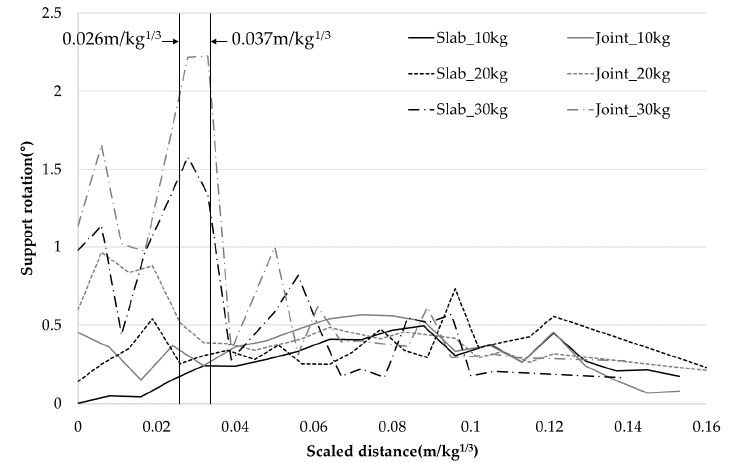
Figure 5. Support rotation of slab.